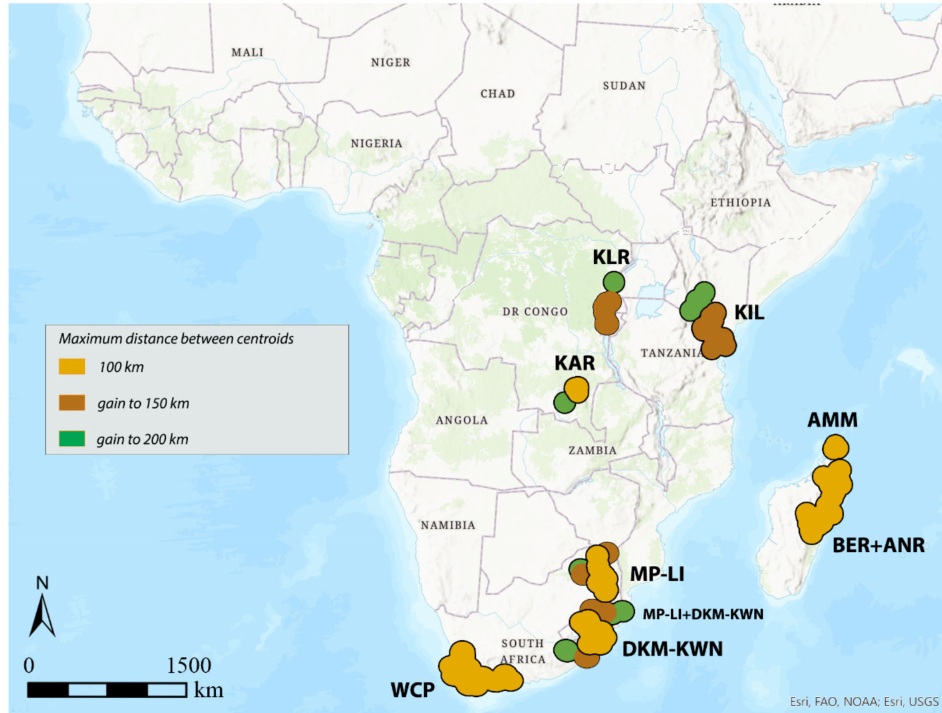
Figure 5. Areas of endemism detected by DBSCAN using species with distribution range up to 300 km and distance between centroids to 100, 150, and 200 km.